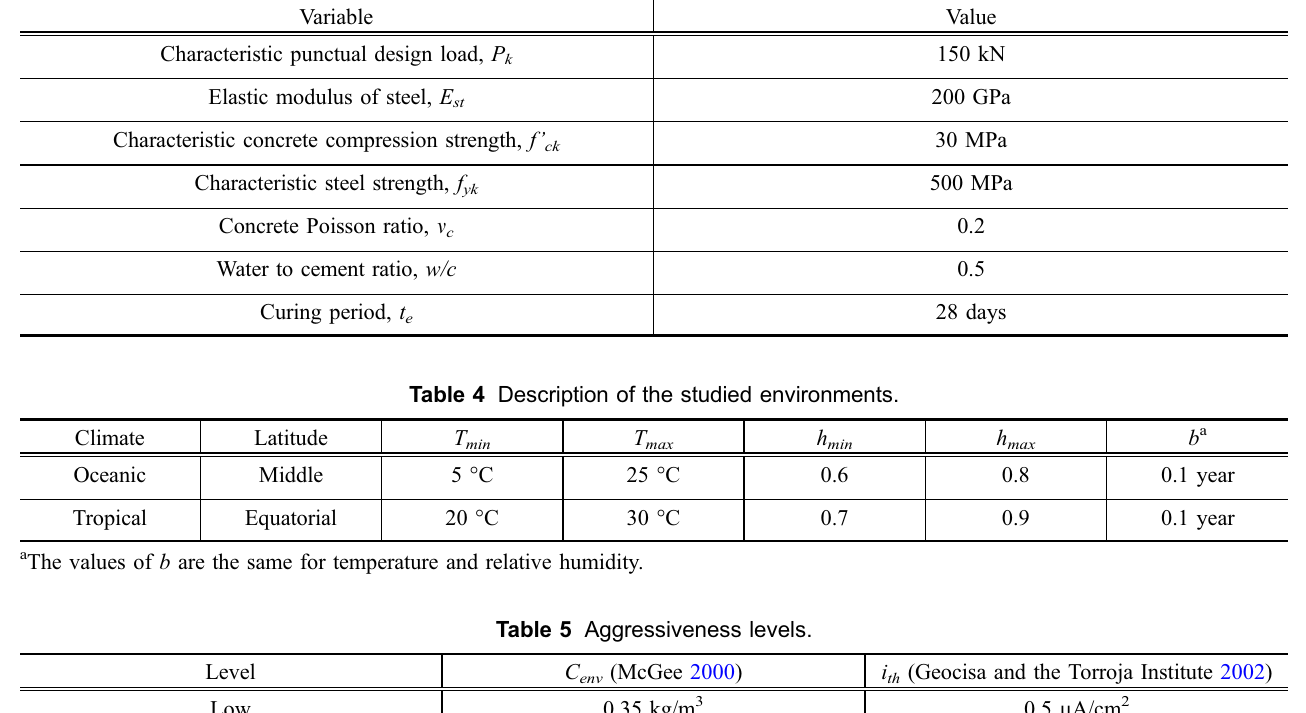
Table 3 Design load and material constants.